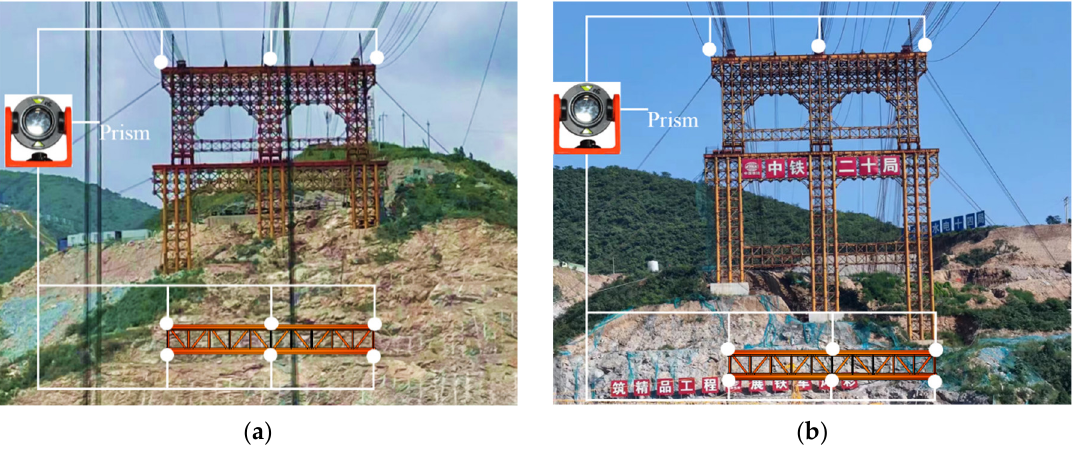
Figure 9. Tower and measurement point layouts for engineering case: ( a ) left bank; ( b ) right bank. Table 5. Maximum measured displacement at tower top (unit: mm).